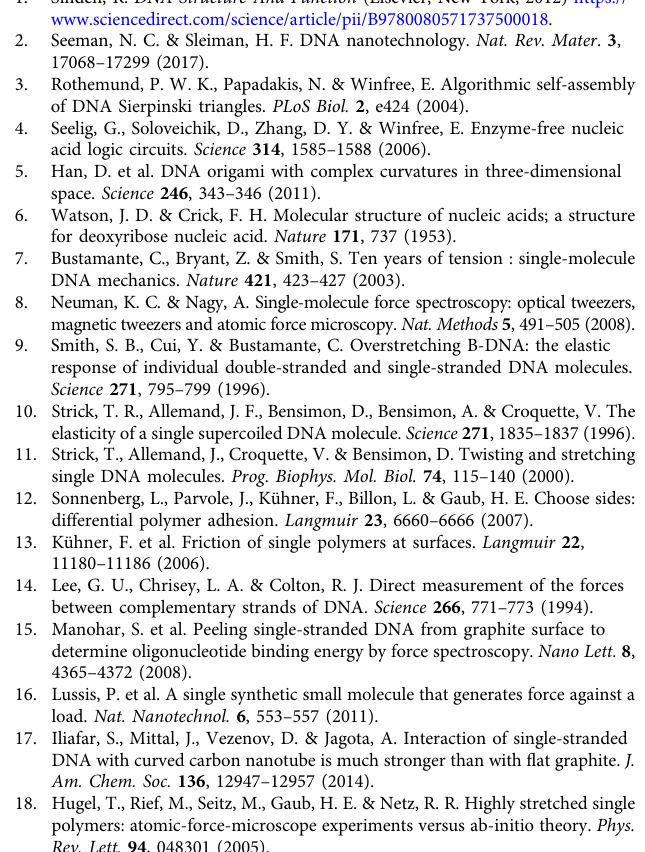
Fig. 3. Here we brie fl y outline each stage. Stage 1: ssDNA oligomer fully embedded in water at 300K. Stage 2: ssDNA inside a water droplet in vacuum at 300 K. Stage 3: Adsorption of a water droplet containing one ssDNA onto a Au(111) surface at 300 K. Stage 3a: Water evaporation at 450K from the same adsorbed droplet. Stage 3b: Evolution of a fully dehydrated ssDNA adsorbed on Au(111) in vacuum at 400 K. Stage 4: Adsorption of a single DNA strand in vacuum onto Au(111) at 400K. Stage 5: Diffusion and self-assembly of two ssDNA molecules adsorbed on Au(111) in vacuum at 400 and 500K. Stage 6: Lifting a ssDNA molecule adsorbed on Au (111) in vacuum at 5K. In all simulations, 19 Na + counterions per ssDNA molecule were included to ensure overall charge neutrality. Data availability The data that support the fi ndings of this study are available from the corresponding authors upon reasonable